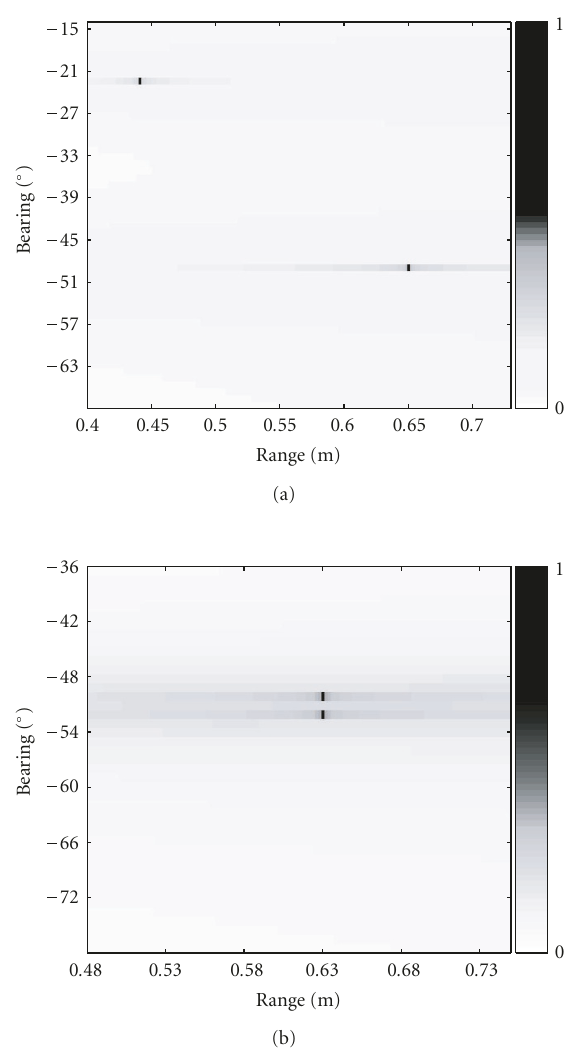
Figure 7: Spatial spectra of the developed method: zoom in range- bearing plane. (a) E 5( O